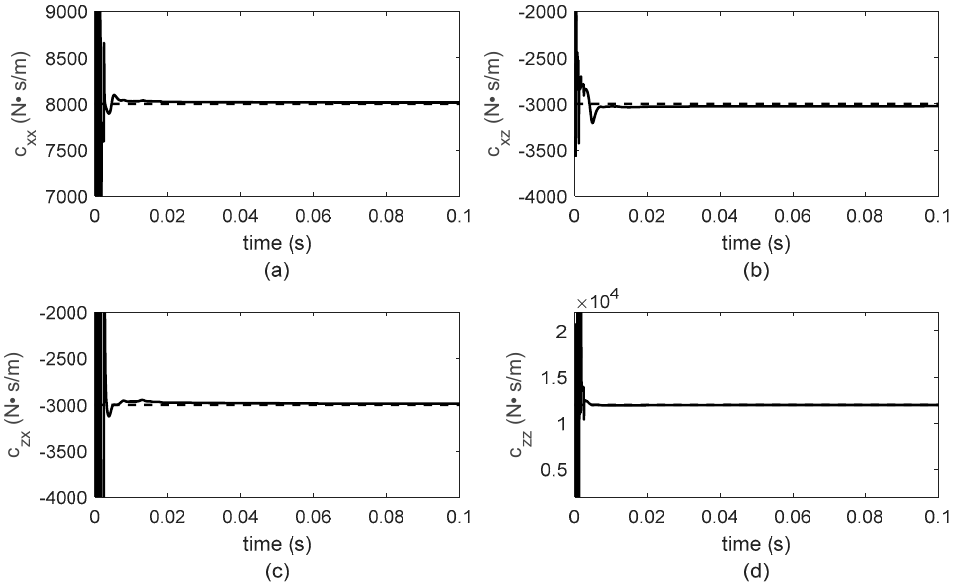
Figure 6. Identified damping parameters for bearing 1 at 600 rpm. ( a ) (cid:1855) (cid:3051)(cid:3051) , ( b ) (cid:1855) (cid:3051)(cid:3053) , ( c ) (cid:1855) (cid:3053)(cid:3051) , ( d ) (cid:1855) (cid:3053)(cid:3053) .